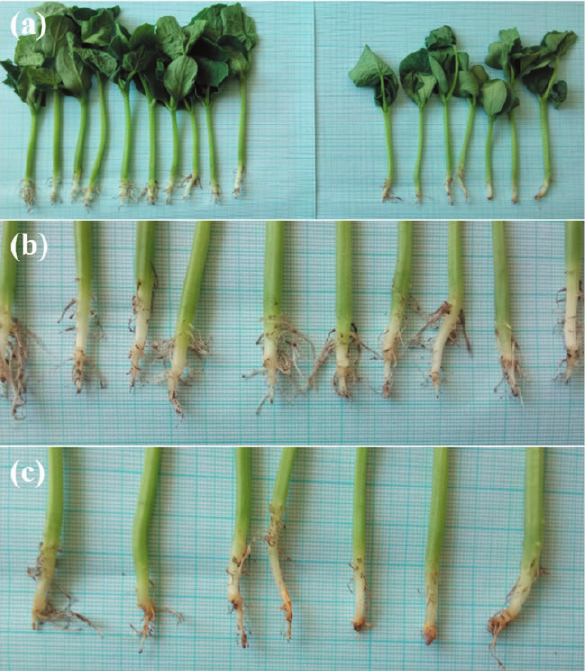
Table 1. Mean diameters of Plectosphaerella melonis (isolate 502) colonies on different nutrient media. Nutrient medium